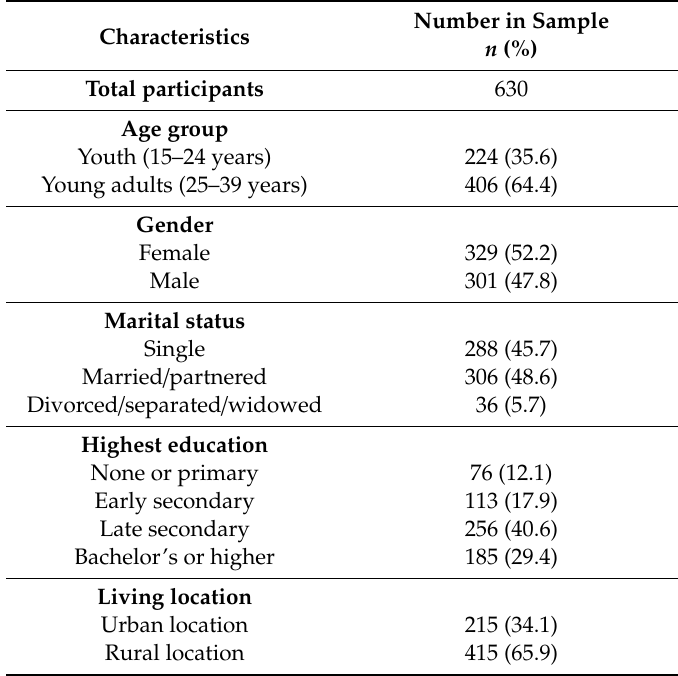
Table 1. Sociodemographic characteristics (aged 15–39